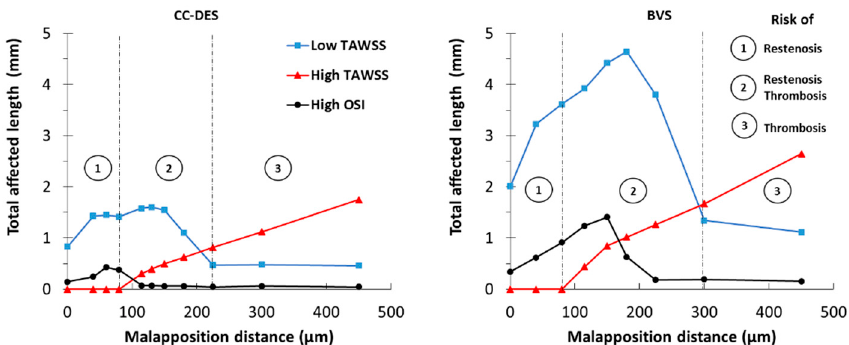
Figure 8. Evolution of affected arterial length vs. malapposition distance (MD). High risk of restenosis (zone 1), restenosis and thrombosis (zone 2) and mainly thrombosis (zone 3).